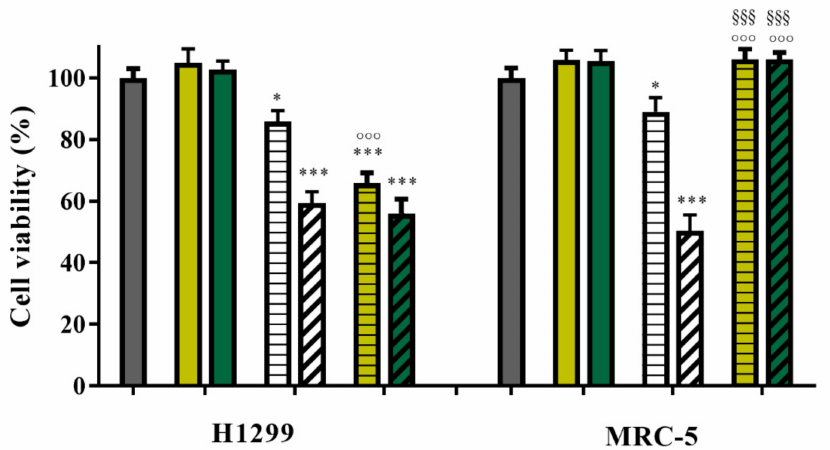
Figure 7. Cell viability of H1299 and MRC-5 cells after treatment with empty CS_MWCNT (filled bar), free MTX (empty streaked bar), and MTX@CS_MWCNT (filled streaked bar). MTX concentrations were 7.72 × 10 − 5 (rowed bar) and 1.51 × 10 − 3 (diagonal bar) mg mL − 1 . CS_MWCNT concentrations were 7.72 × 10 − 4 (light green bar) and 1.51 × 10 − 2 (dark green bar) mg mL − 1 . * p < 0.01, *** p < 0.0001, vs. corresponding control; ◦◦◦ p < 0.0001 vs. free MTX at equivalent concentration; §§§ p < 0.0001 vs. same treatment on H1299